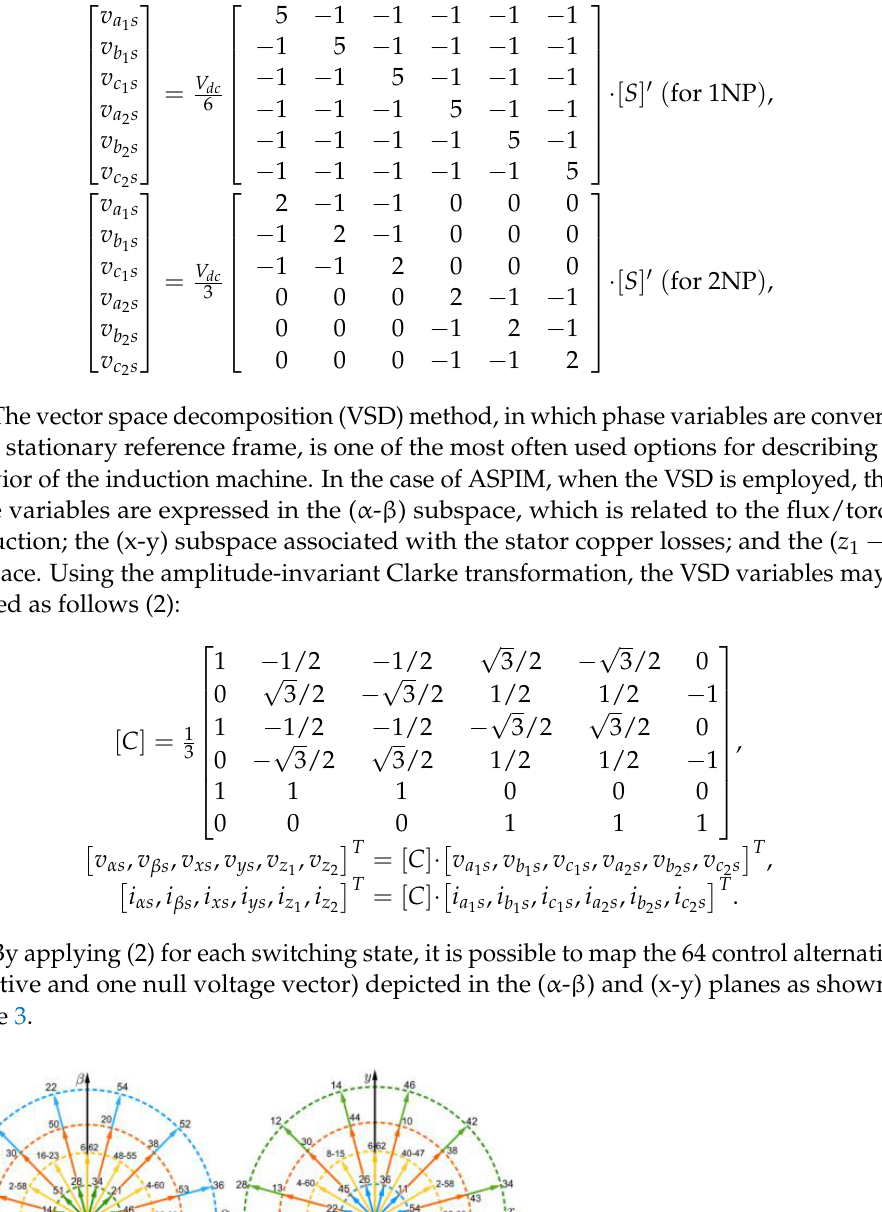
Figure 3. Voltage vectors in α-β and x-y subspaces for an ASPIM.